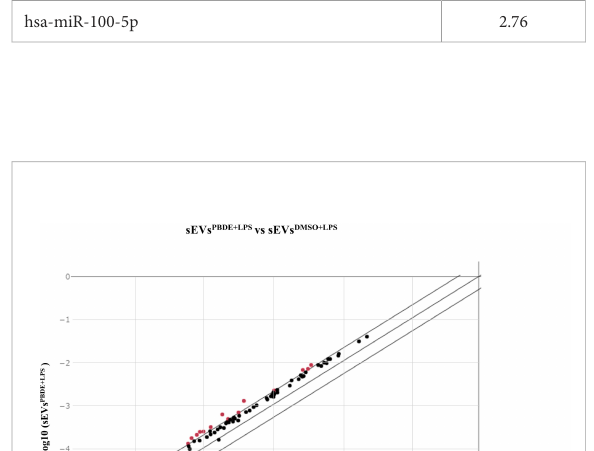
FIGURE 1 Scatterplot of miRNA microarray analysis. CT data from samples (sEVs PBDE+LPS ) and control (sEVs DMSO+LPS ) were analyzed with the GeneGlobe miRCURY LNA miRNA PCR Data Analysis tool (https://dataanalysis2.qiagen.com/miRCury). MiRNAs were considered down-regulated if the fold change was <0.5 (green dot) and up-regulated if the fold change was >2 (red dots); in black are reported the unchanged miRNAs with respect to control (sEVs DMSO+LPS ). Normalization for the fold change calculation was performed using UniSp6 exogenous control and the geNorm (Prede fi ned reference miRNA only) function.